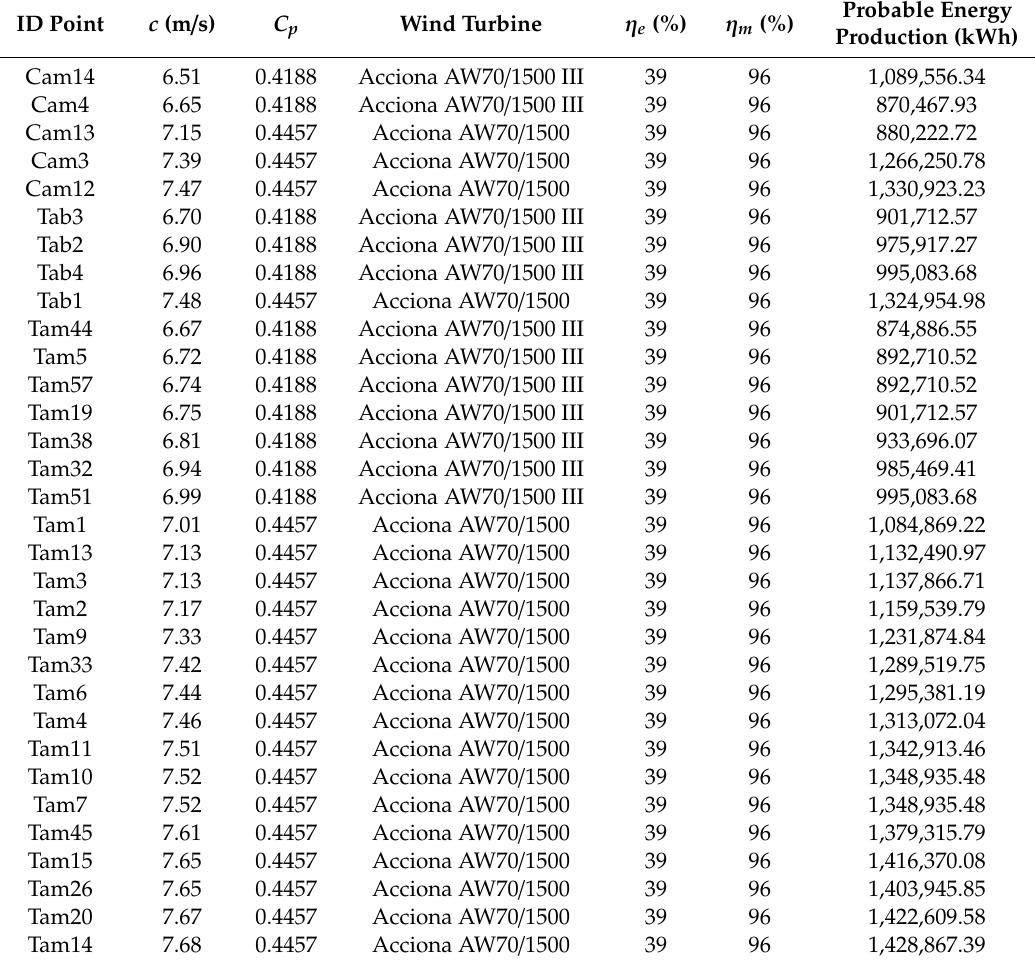
Table 3. Wind turbine